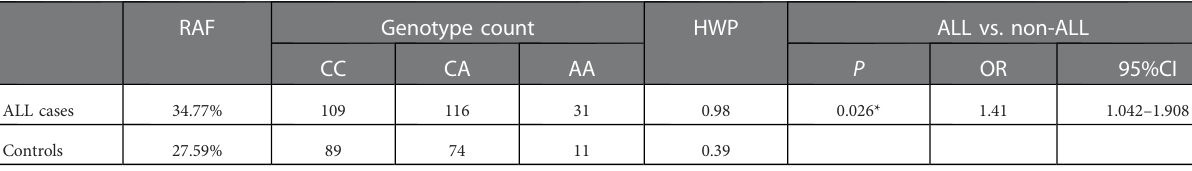
TABLE 1 Comparison of GATA3 rs3824662 between ALL patients and